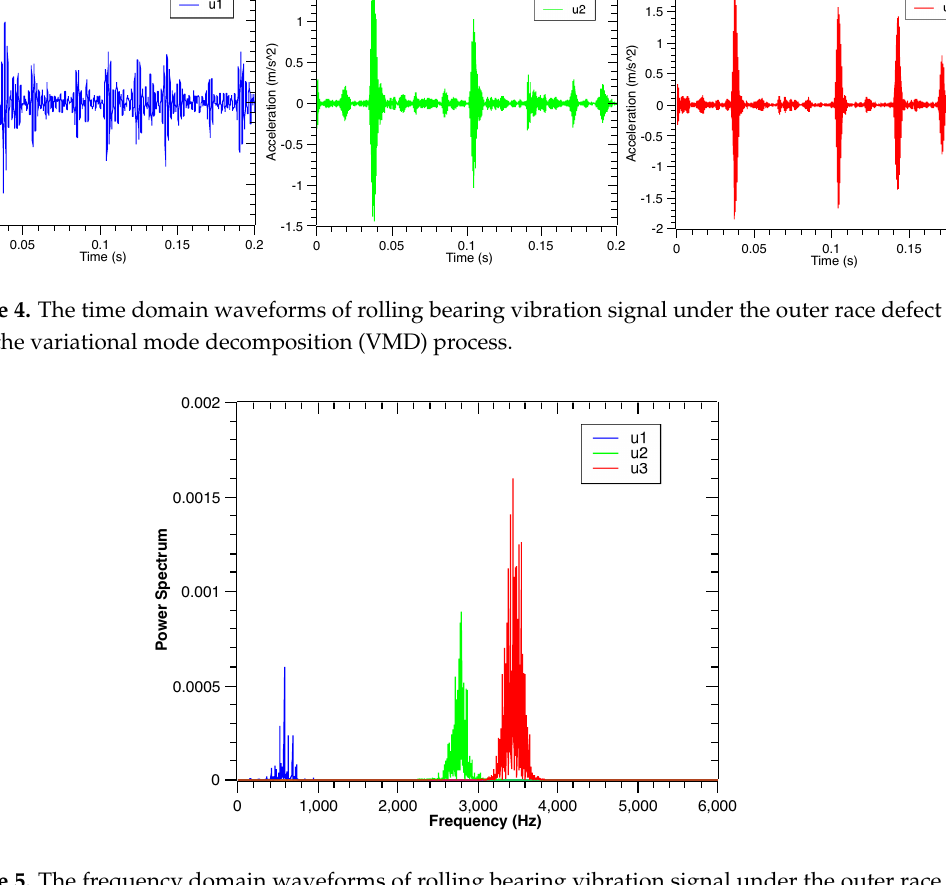
Figure 5. The frequency domain waveforms of rolling bearing vibration signal under the outer race defect after the VMD process.